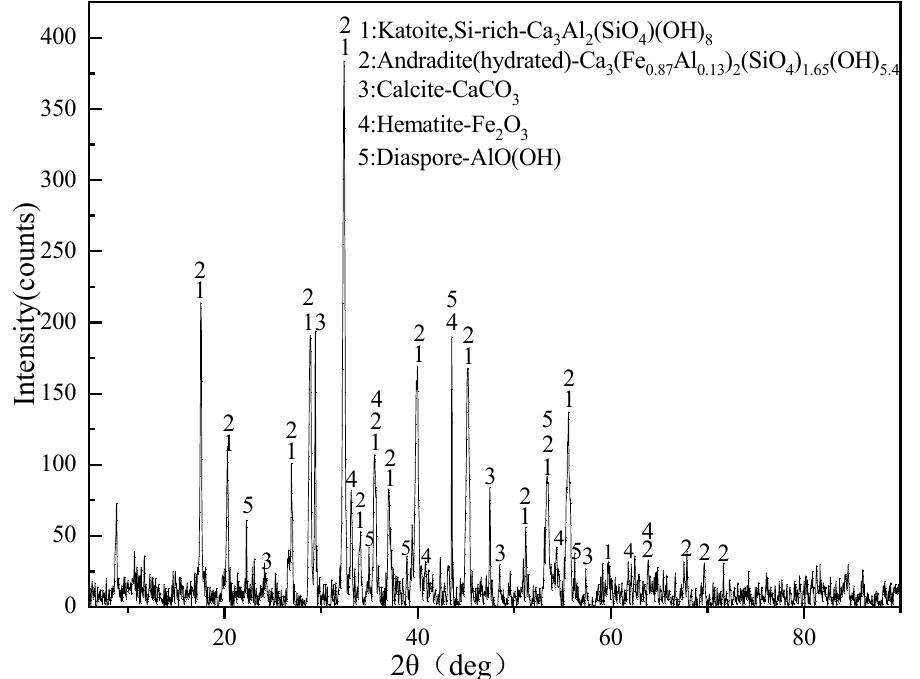
Figure 14. The XRD pattern of the slag after dealkalization. It is shown that the main minerals in the slag after dealkalization are katoite, andradite, calcite, hematite, and diaspore. Above all, the alkali in red mud is mainly a chemically bonded alkali in the form of sodium silicate slag (Na 2 O · Al 2 O 3 · nSiO 2 · mH 2 O), except for some attached alkali. The dealkalization process of adding CaO to red mud is expected to change the sodium silicon slag in red mud into calcium silicon slag (3CaO · Al 2 O 3 · n SiO 2 · (6 − 2 n )H 2 O) under hydrothermal condition. The Na 2 O in sodium silicon slag entered the solution to achieve the goal of dealkalization. Except for the main reaction, the other alkali components in red mud, such as Na 2 CO 3 and Na 2 SiO 3 , can also react with Ca(OH) 2 to form insoluble substances and enter red mud. The above reaction process is verified by the results shown in Figure 14.